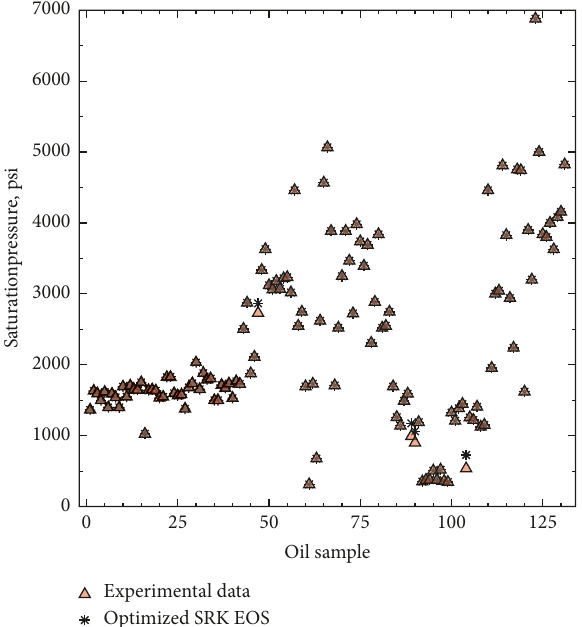
Figure 3: Comparison of saturation pressure using the SRK EOS with optimized binary interaction coefficients and laboratory